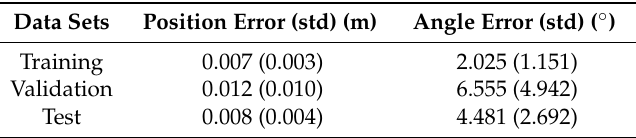
Table 2. MAE for training, validation, and test sets.